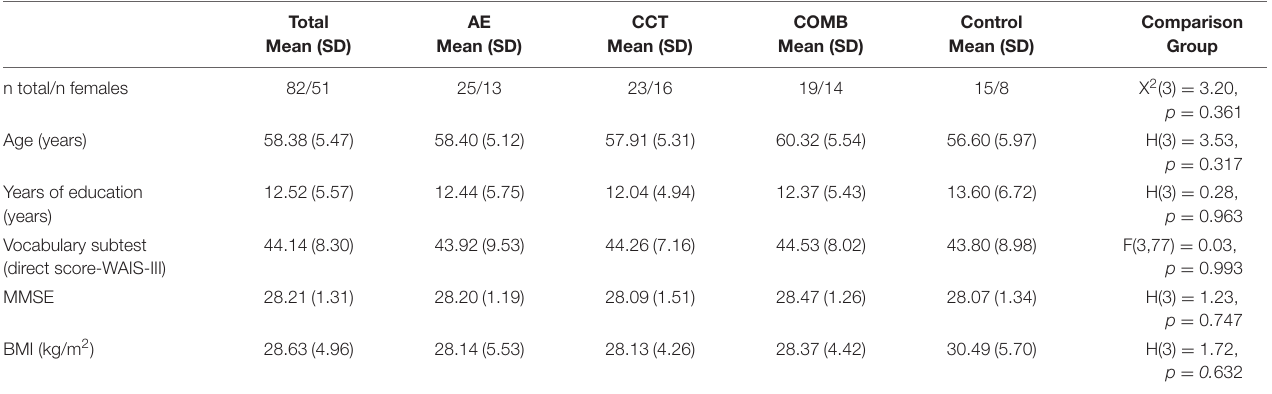
TABLE 2 | Participants characteristics in the PP sample at baseline.